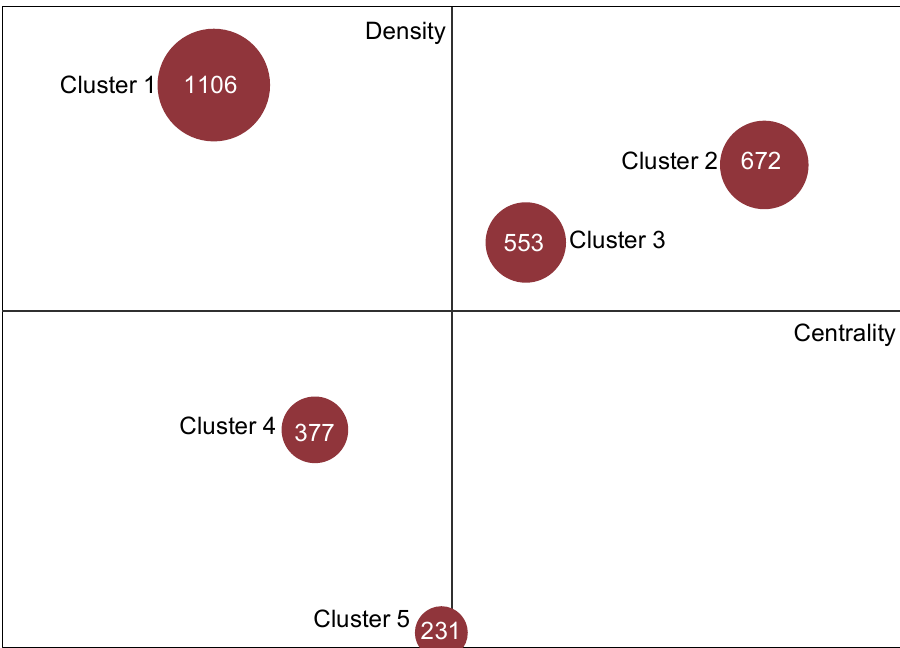
Figure 4. Strategic diagram based on number of papers published.